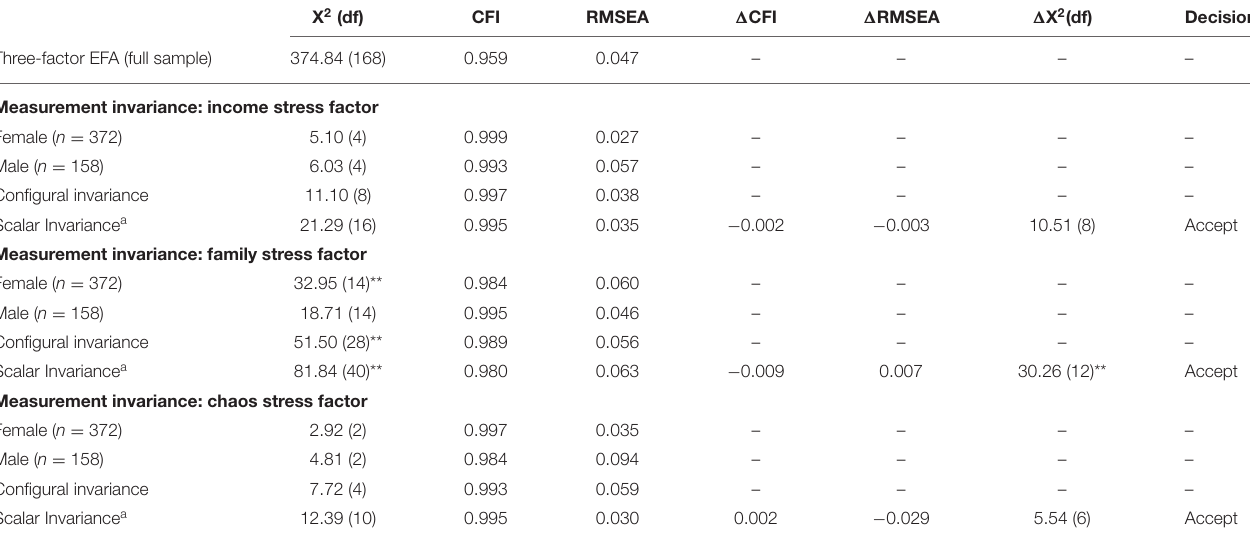
TABLE 3 | Structural and measurement invariance model fit